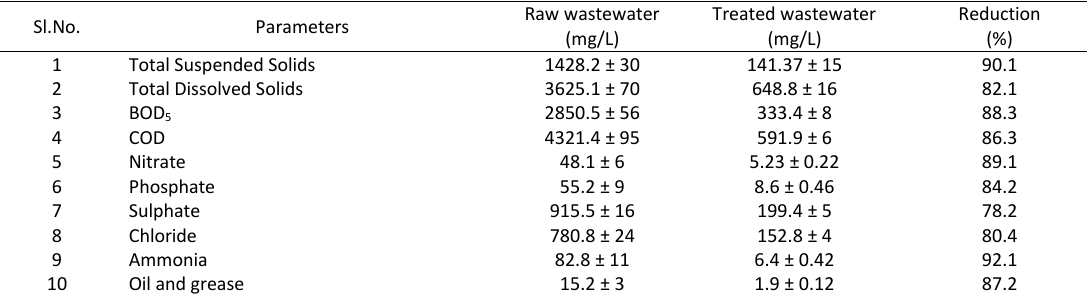
Table 8: The pollutants removal percentage of dairy industry wastewater using DCSB-MFC Sl.No.